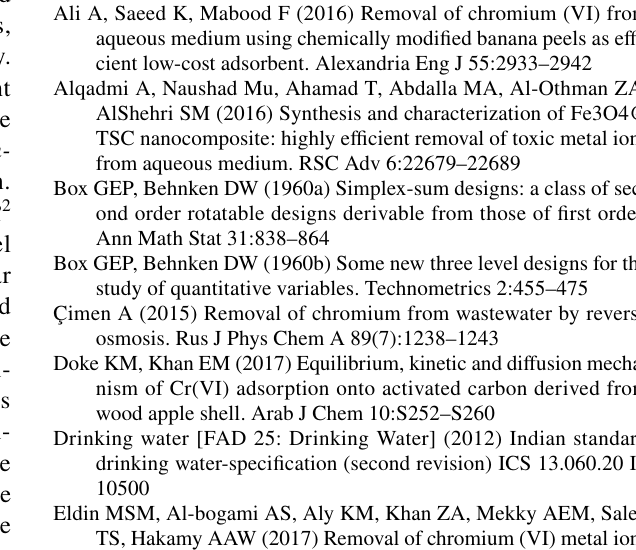
Fig. 5 Probability chart for Chi-square